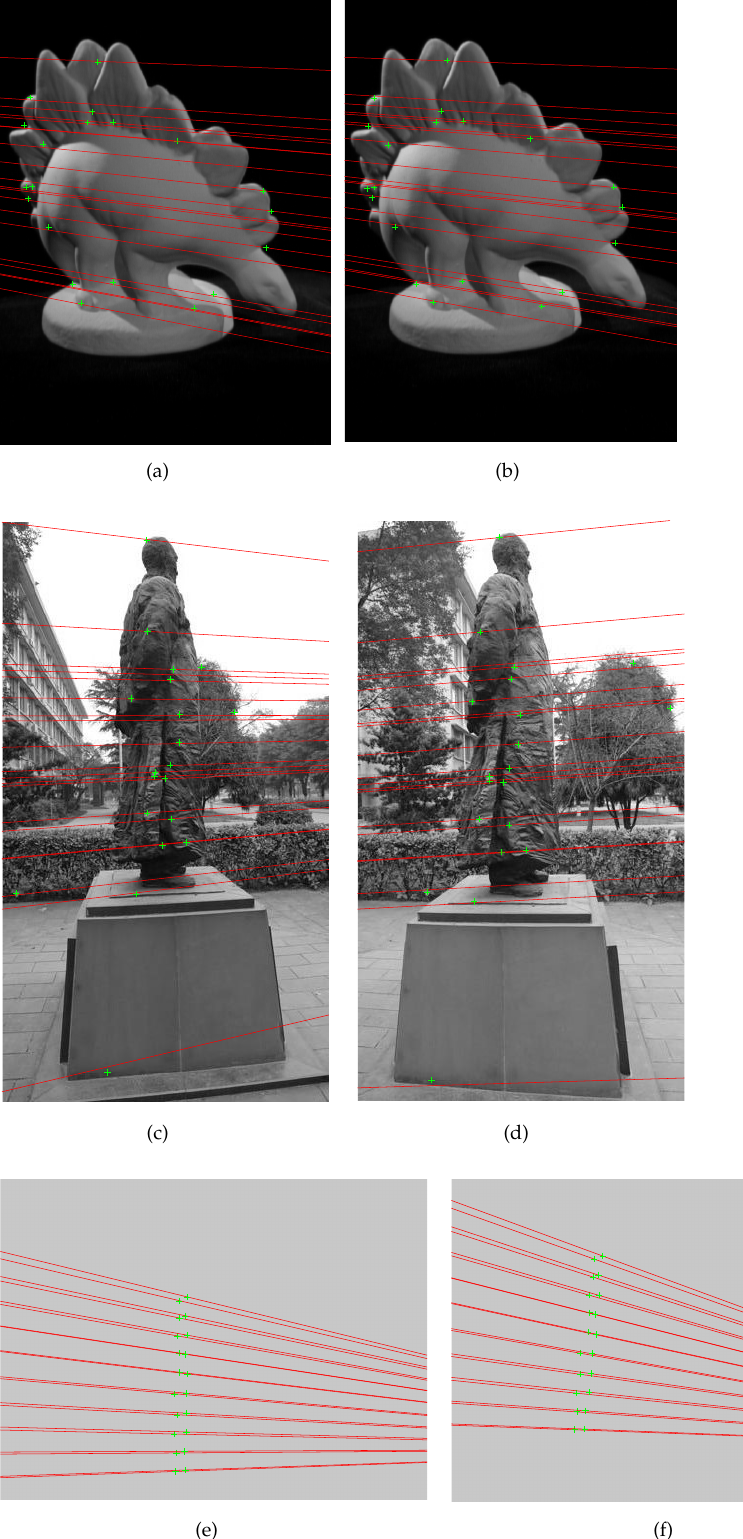
Figure 4. The epipolar lines and features of Dino ( a , b ), ZhangLan ( c , d ), and Simu ( e , f ). Here, only 20 epipolar lines were drawn in case all the lines concentrated in one image are too dense for